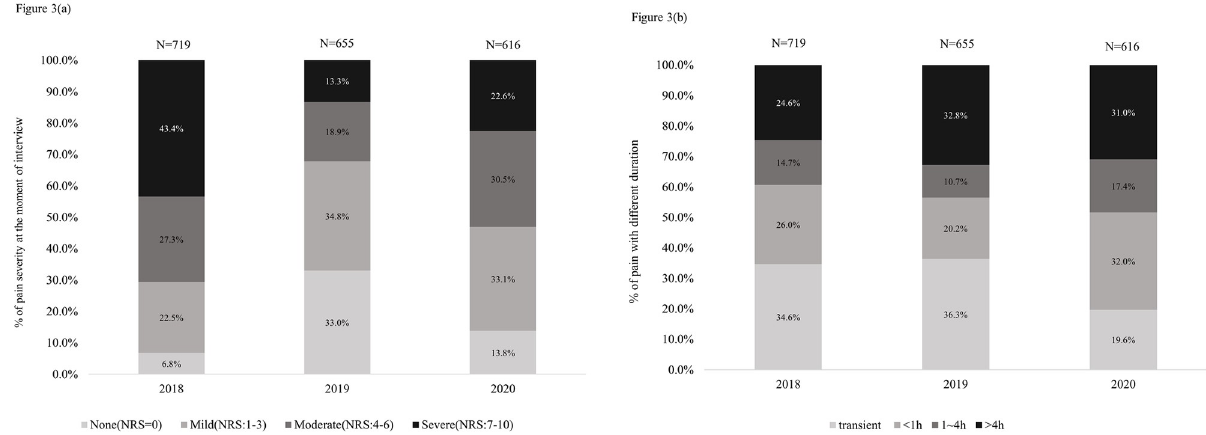
Fig 3. The changes of pain severity (a) and pain duration (b) among the hospitalized patients with pain from 2018 to 2020.